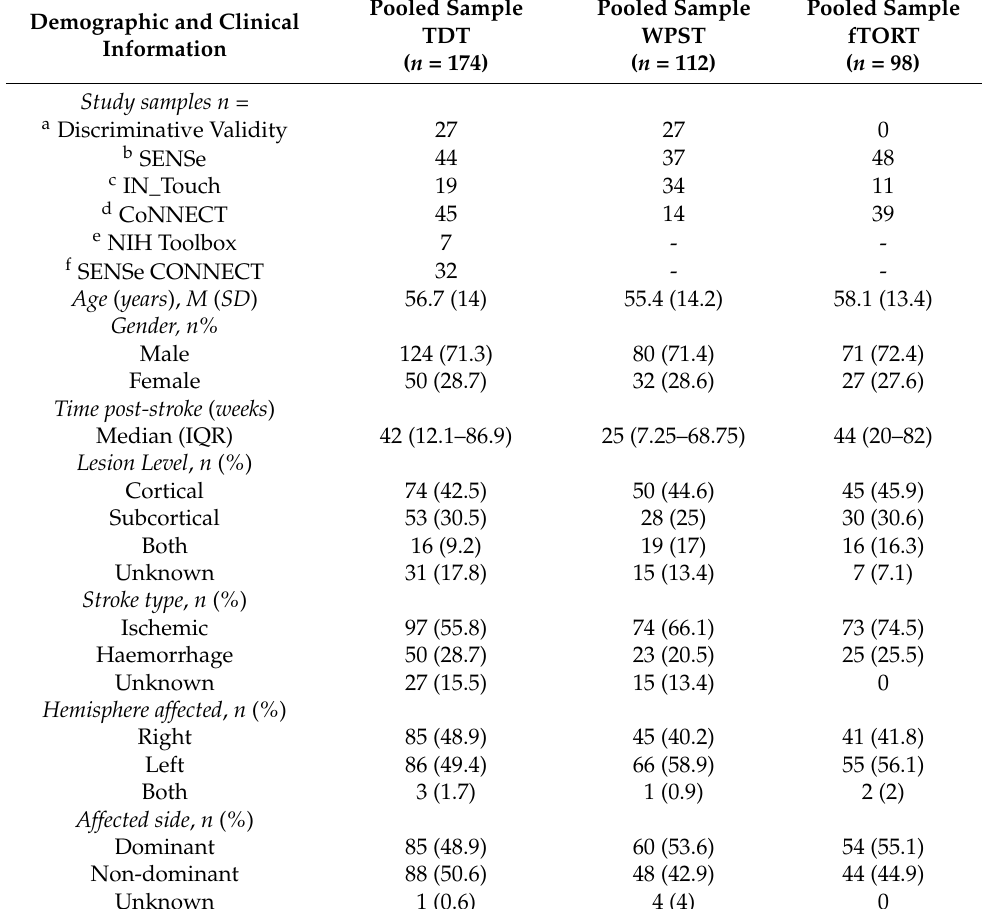
Table 1. Demographic and clinical characteristics of pooled stroke sample for TDT, WPST, and fTORT across pooled